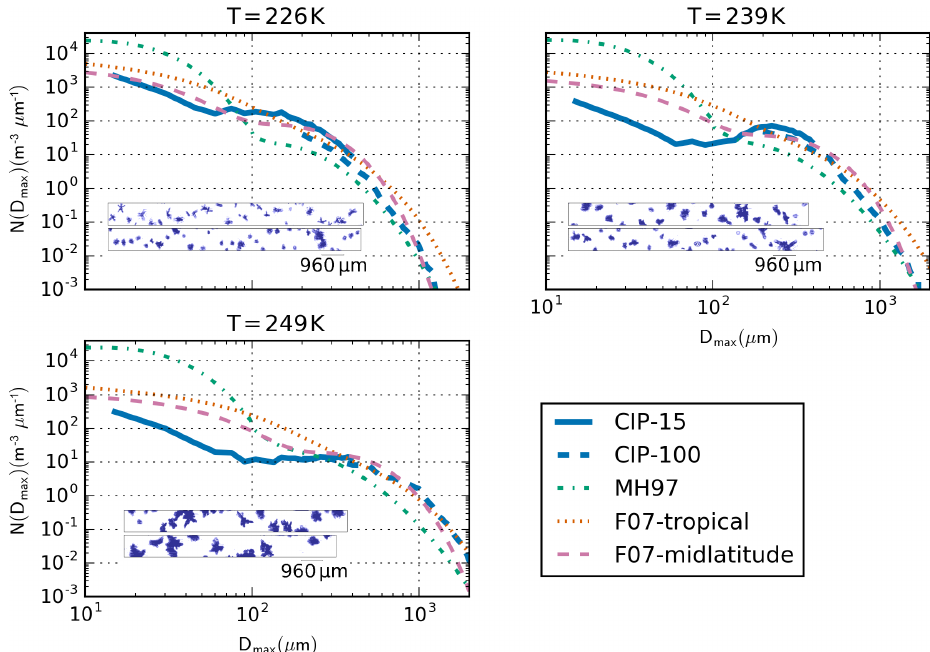
Figure 4. Particle size distributions from in situ runs during flight B939, with example CIP-15 images showing ice crystal